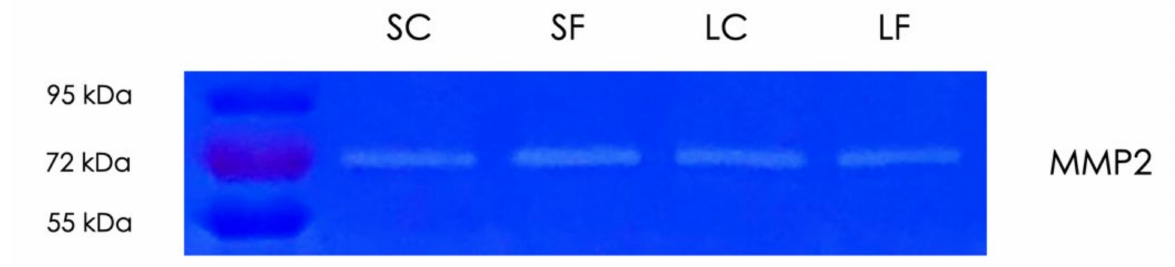
Figure 6. Gelatin zymography of allograft supernatants and acid lysates. Aqueous supernatants of OraGRAFT ® Demineralized Cortical Particulate (SC) and OraGRAFT ® Prime (SF) and the respective acid lysates (LC and LF) were subjected to gelatin zymography. The bands representing the digestion of gelatin indicate the presence of matrix metalloproteinase-2 (MMP2).